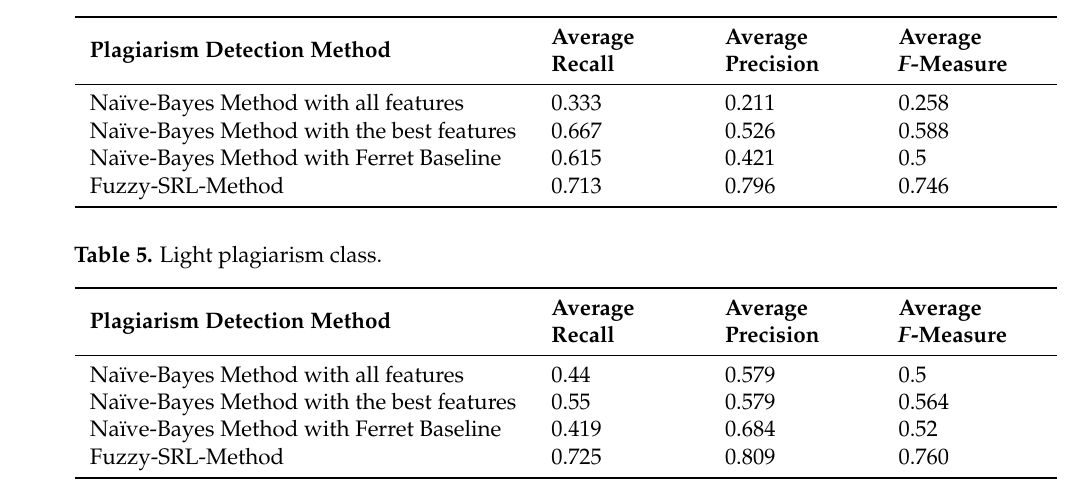
Table 4. Heavy plagiarism class.